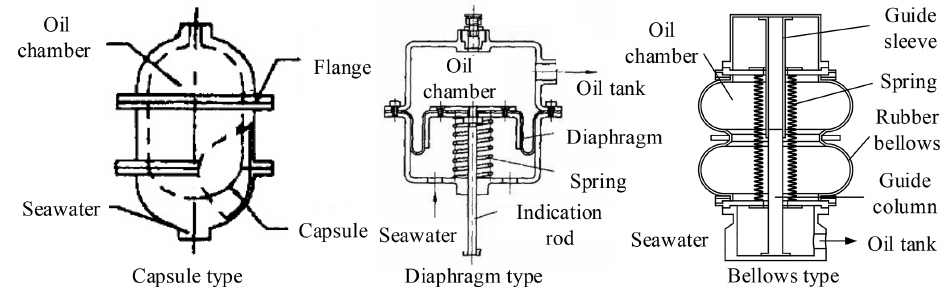
Figure 1. Different types of pressure compensators.